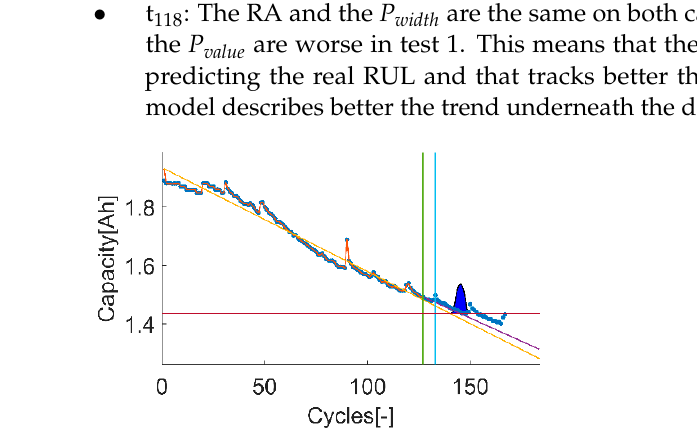
Figure 16. Time-instant figure of test 3 on t 65 .